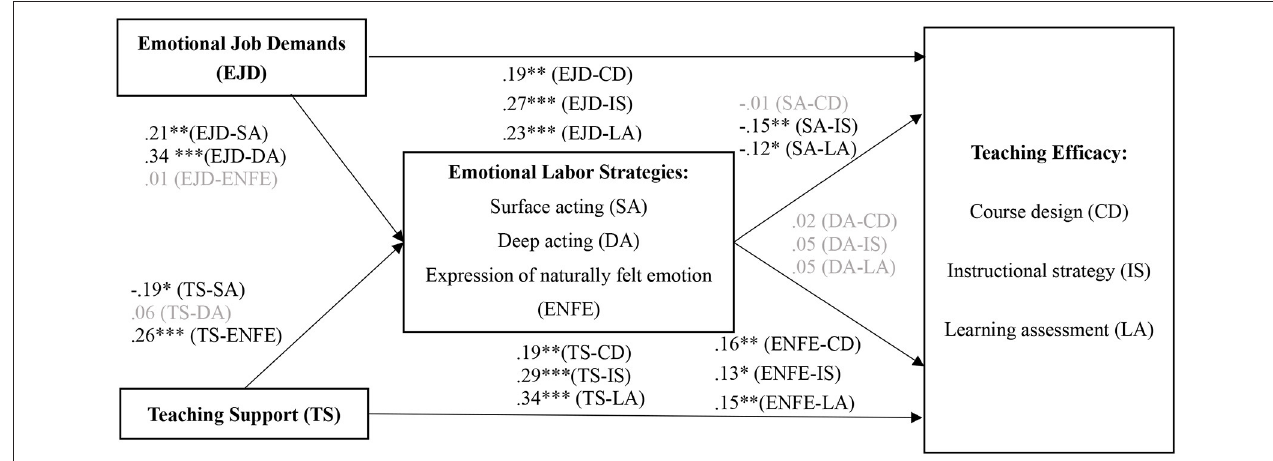
FIGURE 2 | Effects of emotional job demands and teaching support on university teachers’ teaching efficacy via emotional labor strategies ( N = 643). * p < 0.05, ** p < 0.01, *** p < 0.001; Goodness-of-fit indices: χ 2 = 2423.54, df = 831, p < 0.01, CFI = 0.91, TLI = 0.91, SRMR = 0.08, RMSEA =